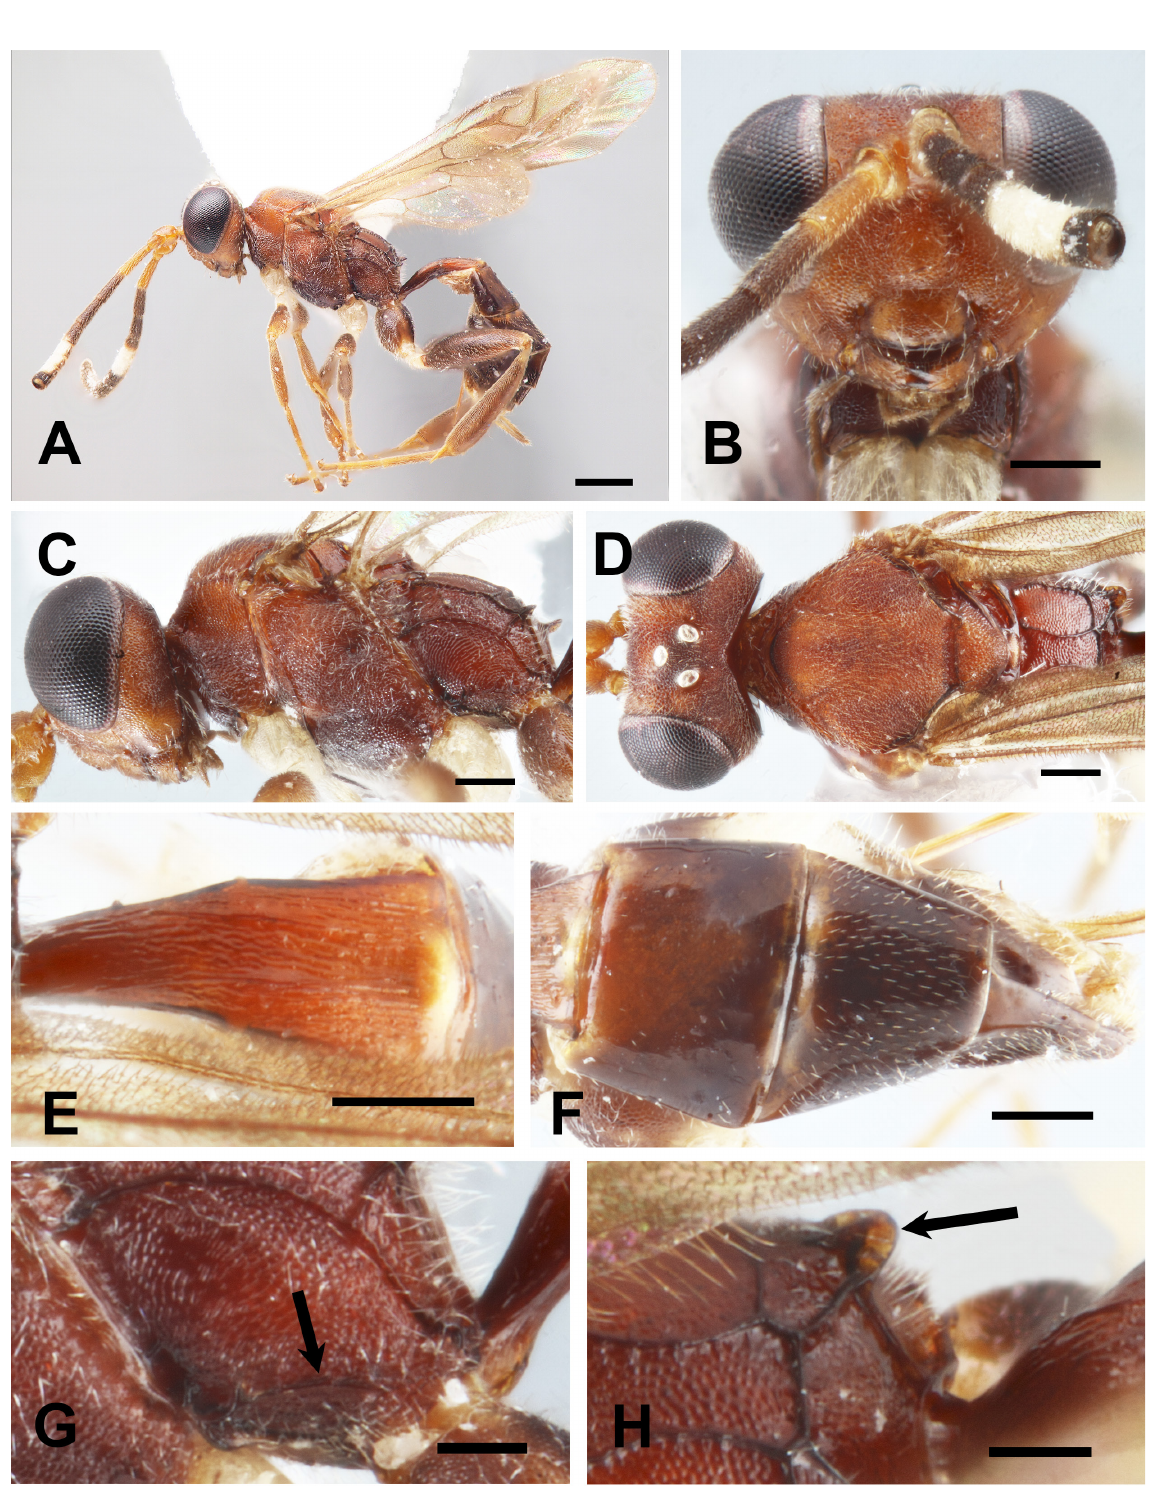
Fig. 7. Morphology of Handaoia ruizcancinoi Bordera sp. nov., holotype, ♀ (CEUA). A . Habitus, lateral view. B . Head, front view. C . Head and mososoma, lateral view. D . Head and mososoma, dorsal view. E . Tergite I, dorsal view. F . Metasoma, dorsal view. G . Metapleuron (arrow: juxtacoxal carina). H . Propodeum (arrow: propodeal apophysis). Scale bars: A = 0.5 mm; B–F = 0.2 mm; G–H = 0.1